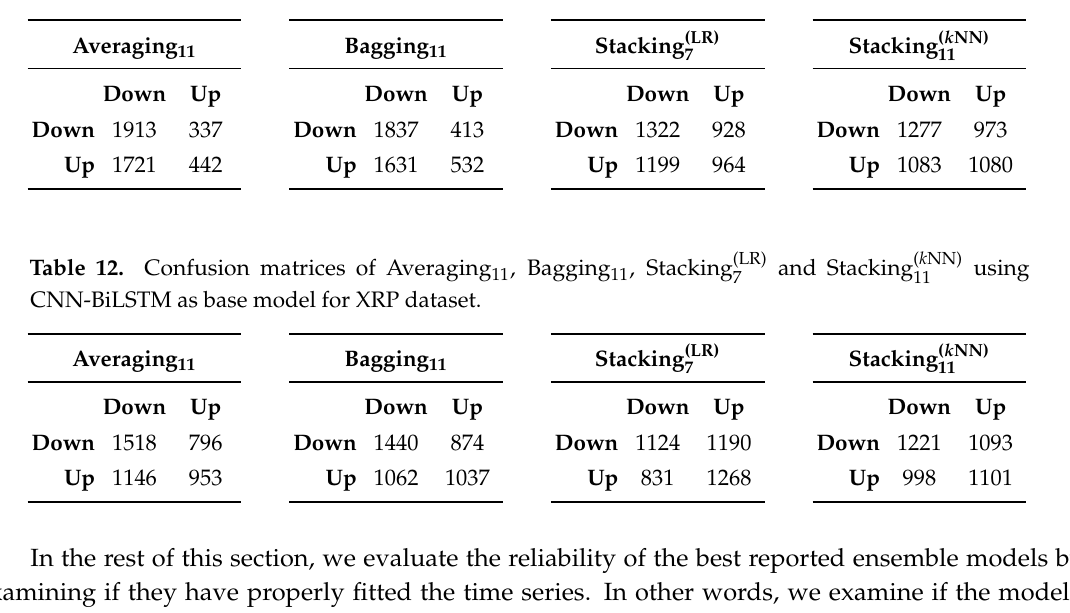
and Stacking ( k NN) using 7 11